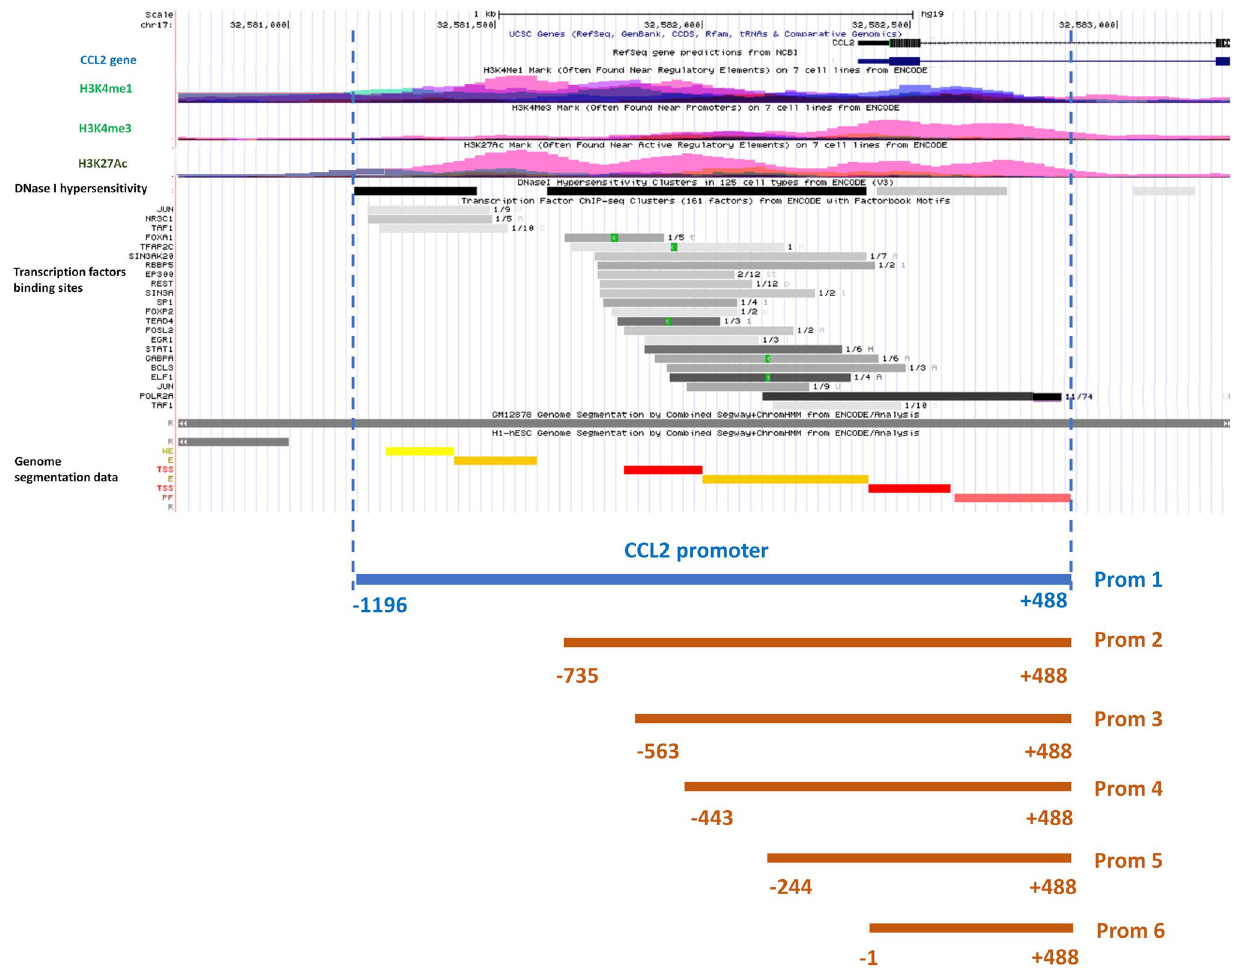
Figure 1. Illustration of the 5 ′ area of the human CCL2 gene (UCSC Genome Browser, Human Feb. 2009 GRCh37/hg19 Assembly) with mapped potential CCL2 promoter variants used for deletion screening. The numbers indicate positions in response to the CCL2 transcription start site. H3K4Me1 the track indicating areas of monomethylation of Histone H3 at lysine 4, H3K4Me3 the track indicating areas of trimethylation of Histone H3 at lysine 4, H3K27Ac the track indicating areas of acetylation of Histone H3 at lysine 27, DNase I hypersensitivity the track indicating deoxyribonuclease I hypersensitivity